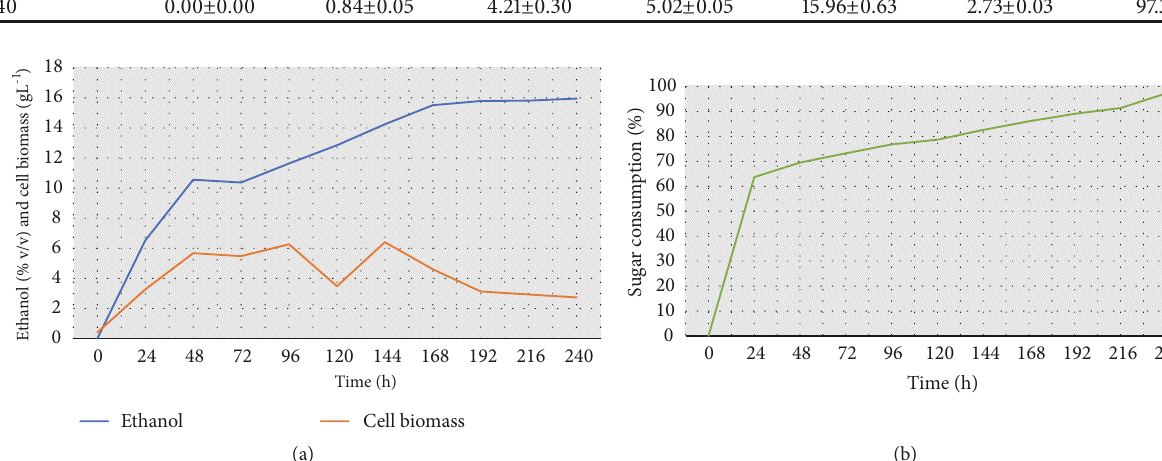
Figure 2: Production of ethanol and cell biomass (a) and the total percentage of sugar consumption (b) during submerged fermentation of cocoa’s residual honey by S. cerevisiae AWRI726 (19 ∘ Brix, 20 ∘ C, and pH